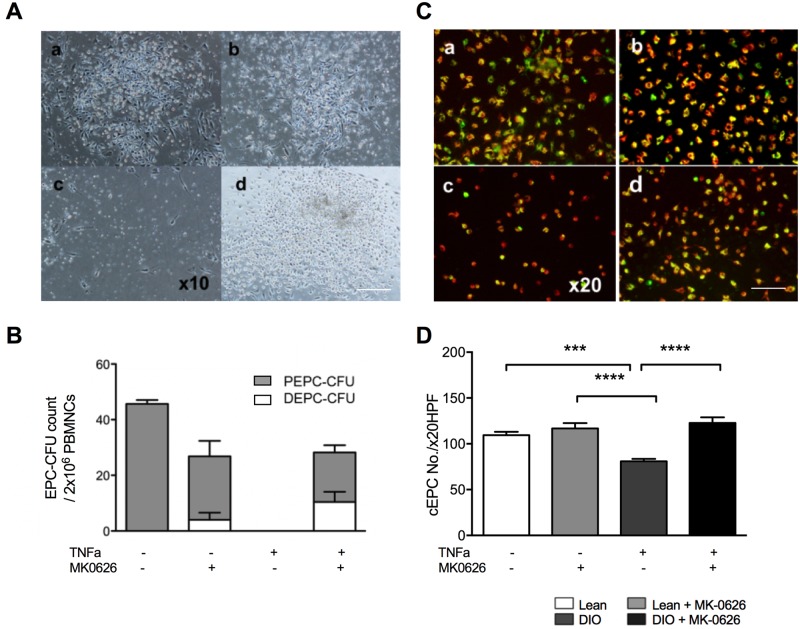
MK-0626 accelerates EPC differentiation under inflammatory conditions.(A) Representative picture of EPC-CFU generated from hPBMNCs. The images are of following EPCs: control (Aa), MK-0626-treated (Ab), TNFα-treated (Ac) and MK-0626- and TNFα-treated (Ad). These EPC-CFUs were observed under high-power field (HPF) of 10×. (B) The graph shows EPC-CFU counts, generated from hPBMNCs (2 × 105 cells/dish). The bars indicate the values of pEPC-CFU (open) and dEPC-CFU (light gray). (C) Conditioned EPCs (cEPCs) were observed with fluorescence microscope after co-staining with UEA-I Lectine (green) for detection of endothelial cell and DiI-Ac LDL (red) for detection of endothelial and macrophage cell lineages. The images are of following cEPCs: control (Ca), MK-0626-treated (Cb), TNFα-treated (Cc), and MK-0626- and TNFα-treated (Cd). The number of the cEPC was counted under high-power field (HPF) of 20×. Data are represented as the mean ± SE. N = 3 volunteers. Experiments were repeated at least three times. In the graph, *P < 0.05, **P < 0.01, and ***P < 0.001, determined by Two-way ANOVA followed by Tukey’s multiple comparisons test.